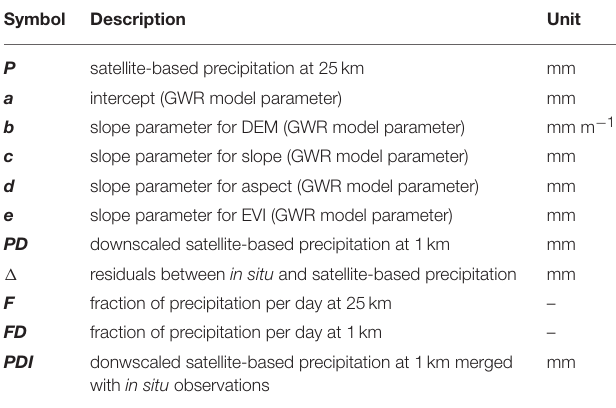
The datasets are sorted alphabetically by acronym.